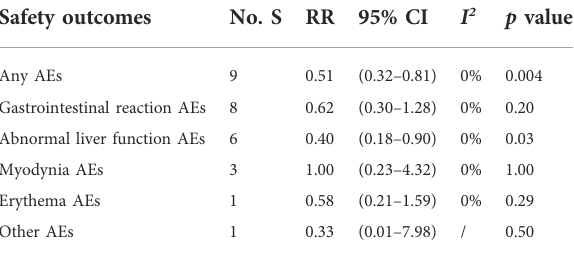
TABLE2Subgroupanalysis ofthemainsafetyoutcomesofZBTvs.CT.